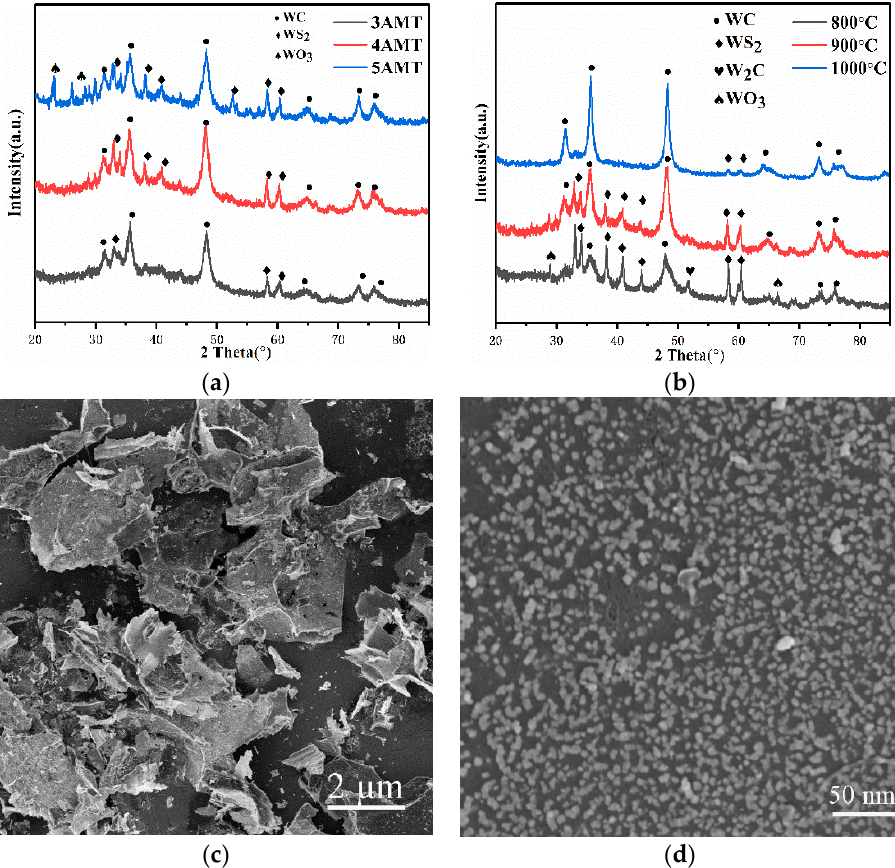
Figure 1. ( a ) X-ray diffraction (XRD) images of 4 ammonium metatungstate (AMT) prepared at different AMT–glucose ratios at 900 °C. ( b ) XRD images of 4 AMT at different temperatures and ( c,d ) scanning electron microscopy (SEM) images of 4 AMT.